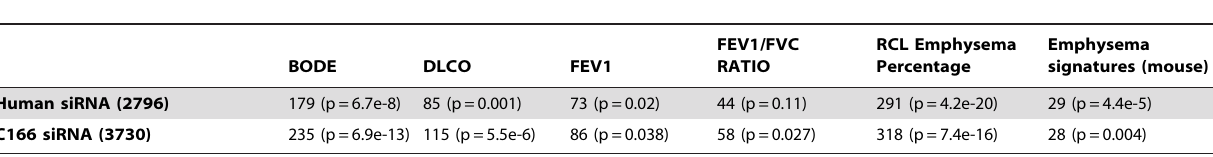
Table 1. EPAS1 siRNA signatures in human and mouse endothelial cells overlap with multiple COPD disease severity related signature